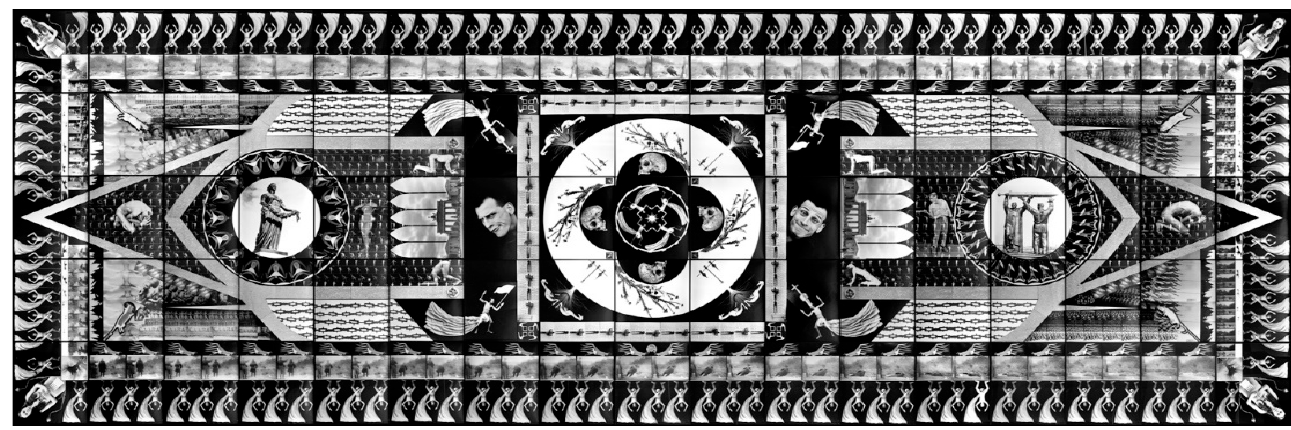
Figure 1. All the Missiles are One Missile ,